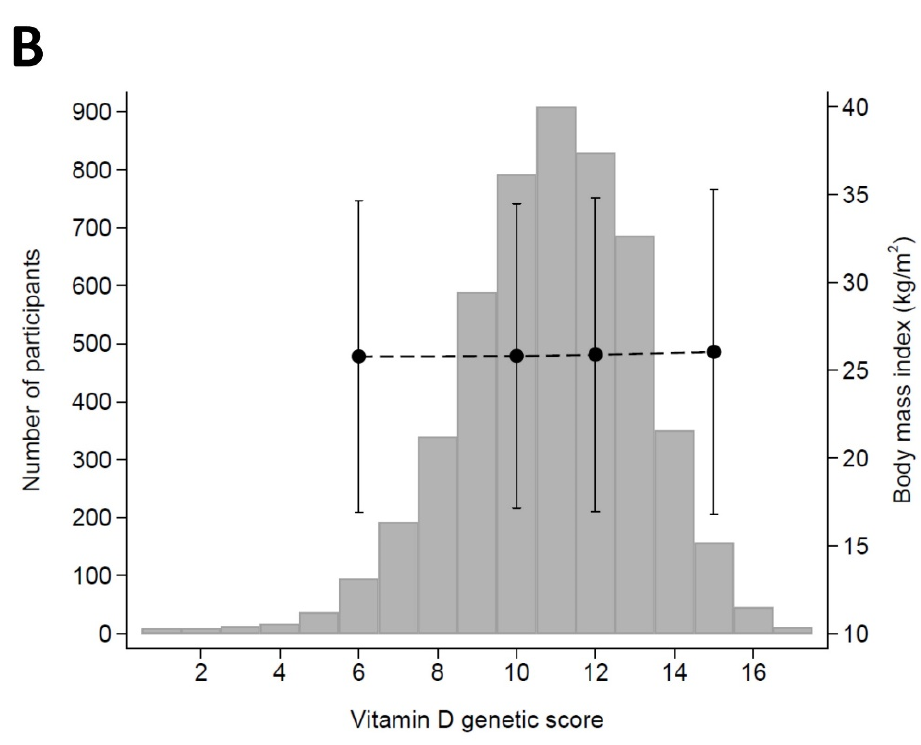
Figure 1. Association between the genetic risk score for vitamin D and 25 ‐ hydroxyvitamin D levels ( panel A ) and body mass index ( panel B ), CoLaus study, Lausanne, Switzerland. The X -axis represents the genetic risk score values, the bars represent the number of participants, and the dots represent 25-hydroxyvitamin D ( panel A ) or body mass index ( panel B ) values and corresponding 95% confidence intervals.